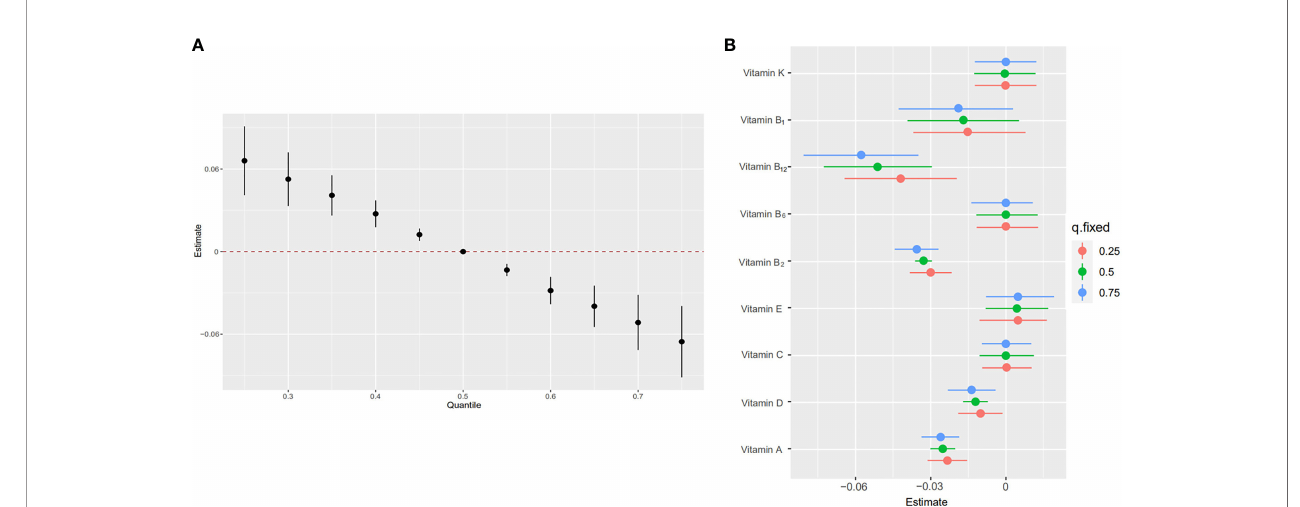
FIGURE 3 | Joint effect [95% con fi dence intervals (CI)] of the fi ve vitamins [vitamin A, vitamin B 1 , vitamin B 2 , vitamin B 6 , vitamin B 12 , vitamin C, vitamin D, vitamin E, vitamin K] on obesity by using Bayesian kernel machine regression (BKMR) model. The results were adjusted for age, sex, education level, race/ethnicity, poverty- income ratio, serum cotinine and daily energy intake. (A) Overall effect of fi ve vitamins (estimates and 95%CI). The fi gure plots the estimated change in a latent continuous outcome (continuous marker of obesity) when all the vitamins at fi xed percentiles were compared to all the vitamins at their 50th percentile. (B) Single vitamin association (estimates and 95% CI, estimated zero means null). This plot compares a latent continuous outcome when a single vitamin is at the 75th vs 25th percentile, when all the other vitamins are fi xed at either the 25th, 50th, or 75th